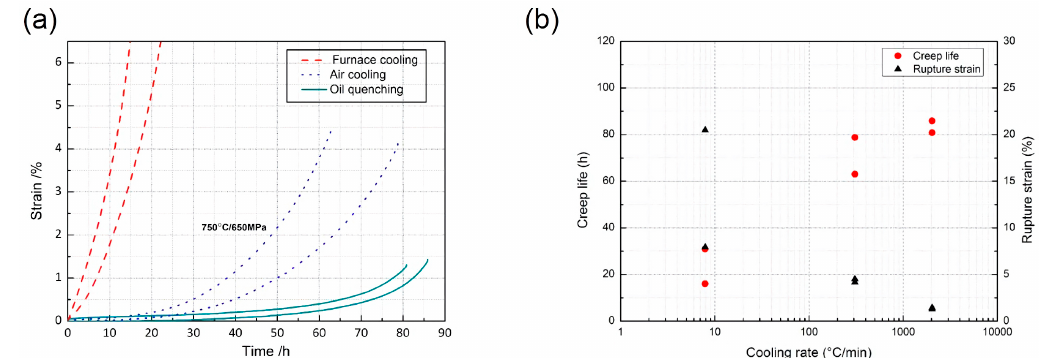
Figure 4. ( a ) Creep curves of alloy with different cooling rates; ( b ) The relationship between cooling rate and creep life as well as rupture strain. Notice that the horizontal axis is logarithmic.